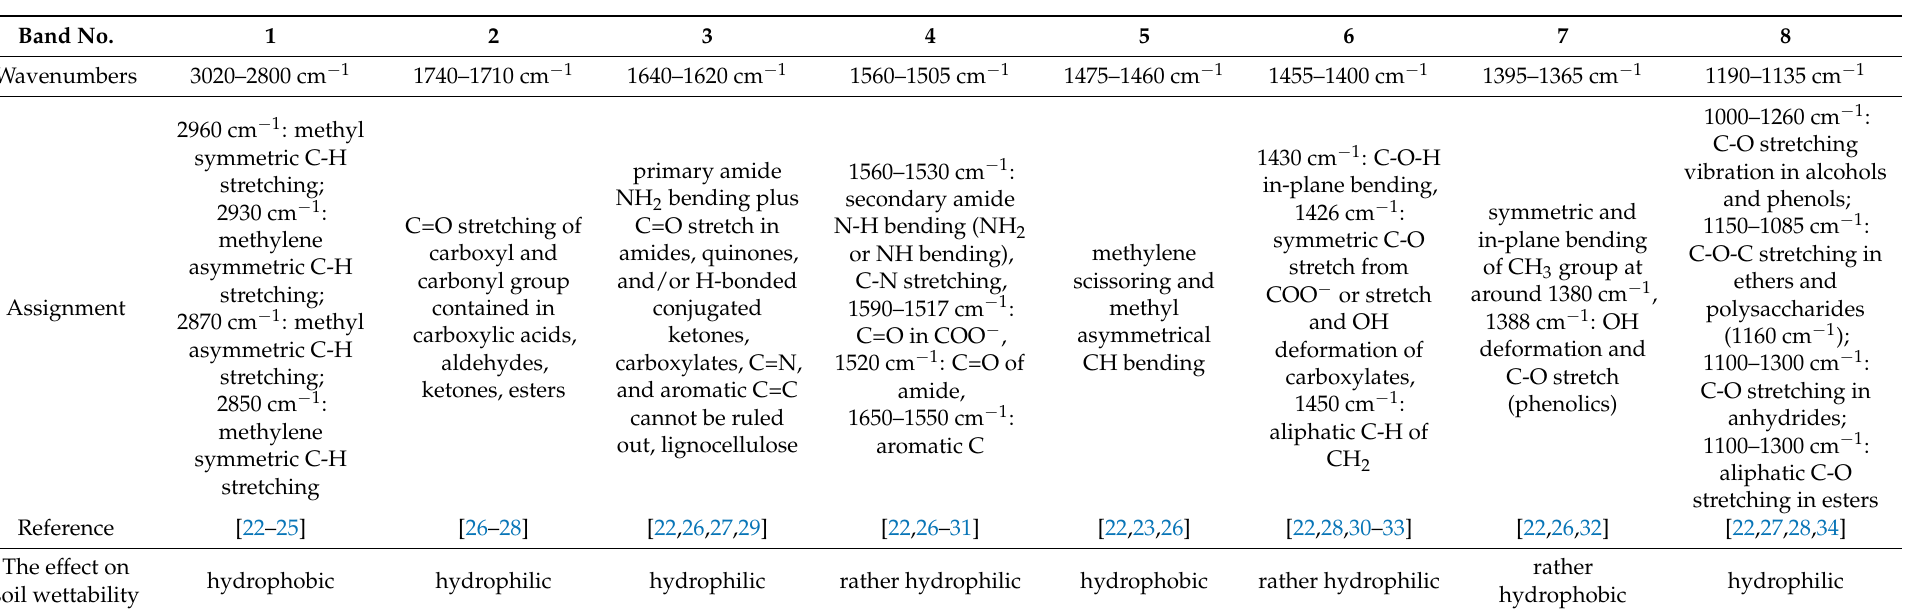
Table 1. Selected IR bands in which the peak areas were calculated. Based on the polarity of bonds, the effect of functional groups on SWR is indicated in the last row. Band